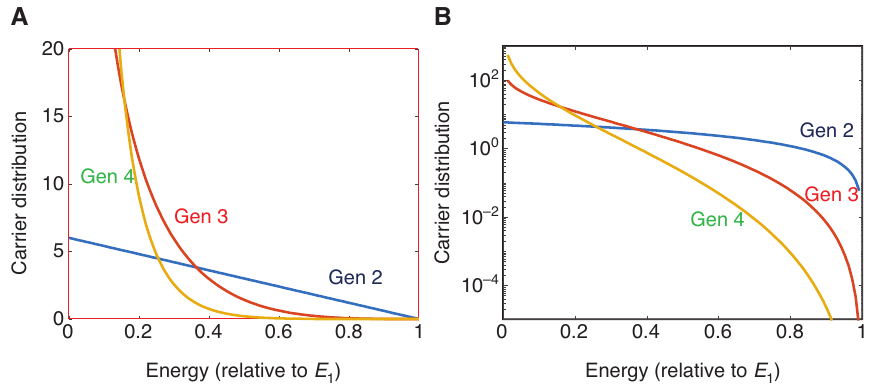
Figure 9: Energy distribution of the second through fourth generation of carriers generated as a result of decay of a single first-generation carrier with energy E 1